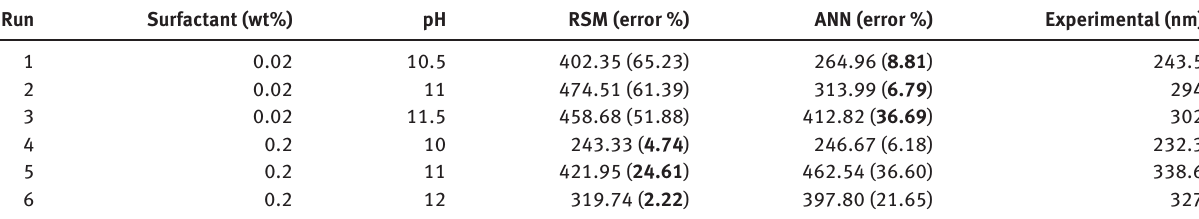
Values in bold represent lower error percentages.